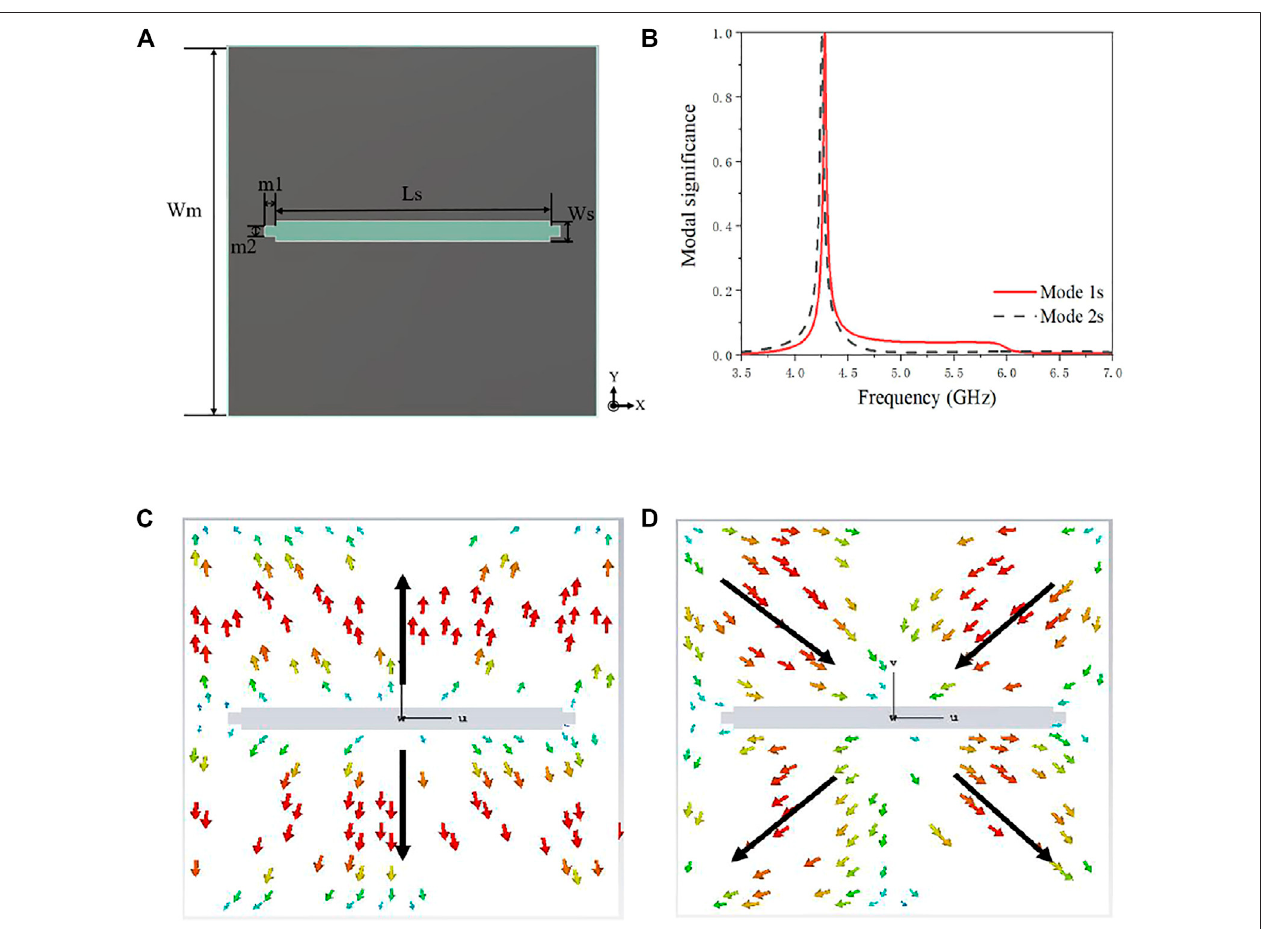
FIGURE4 | Thestructure, MS, and characteristic current ofthe stepped slot patch antenna: (A) Antenna structure; (B) MS; (C) The characteristic current ofMode 1s; (D) The characteristic current of Mode 2s.